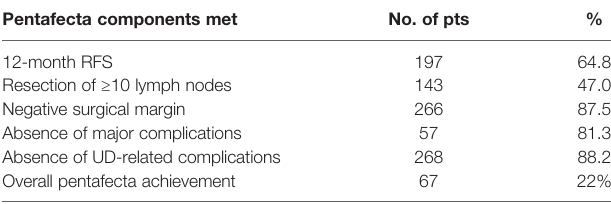
RFS, recurrence-free survival; UD, urinary